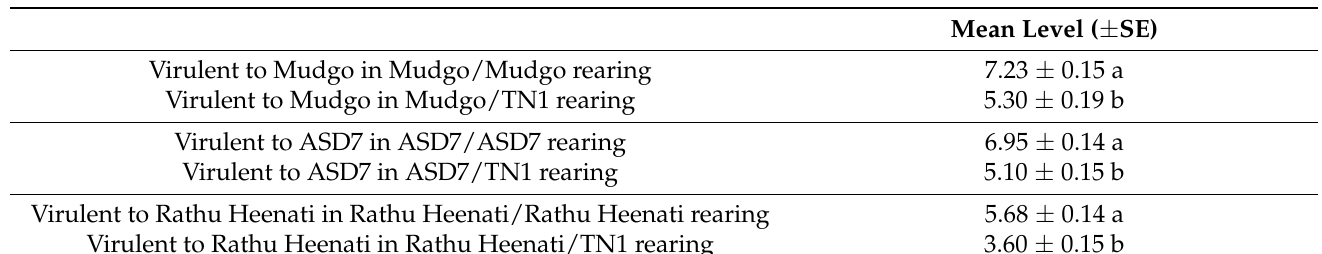
Table 2. Mean virulence levels of different BPH populations after five generations of selection, evaluated using the standard seedbox screening test